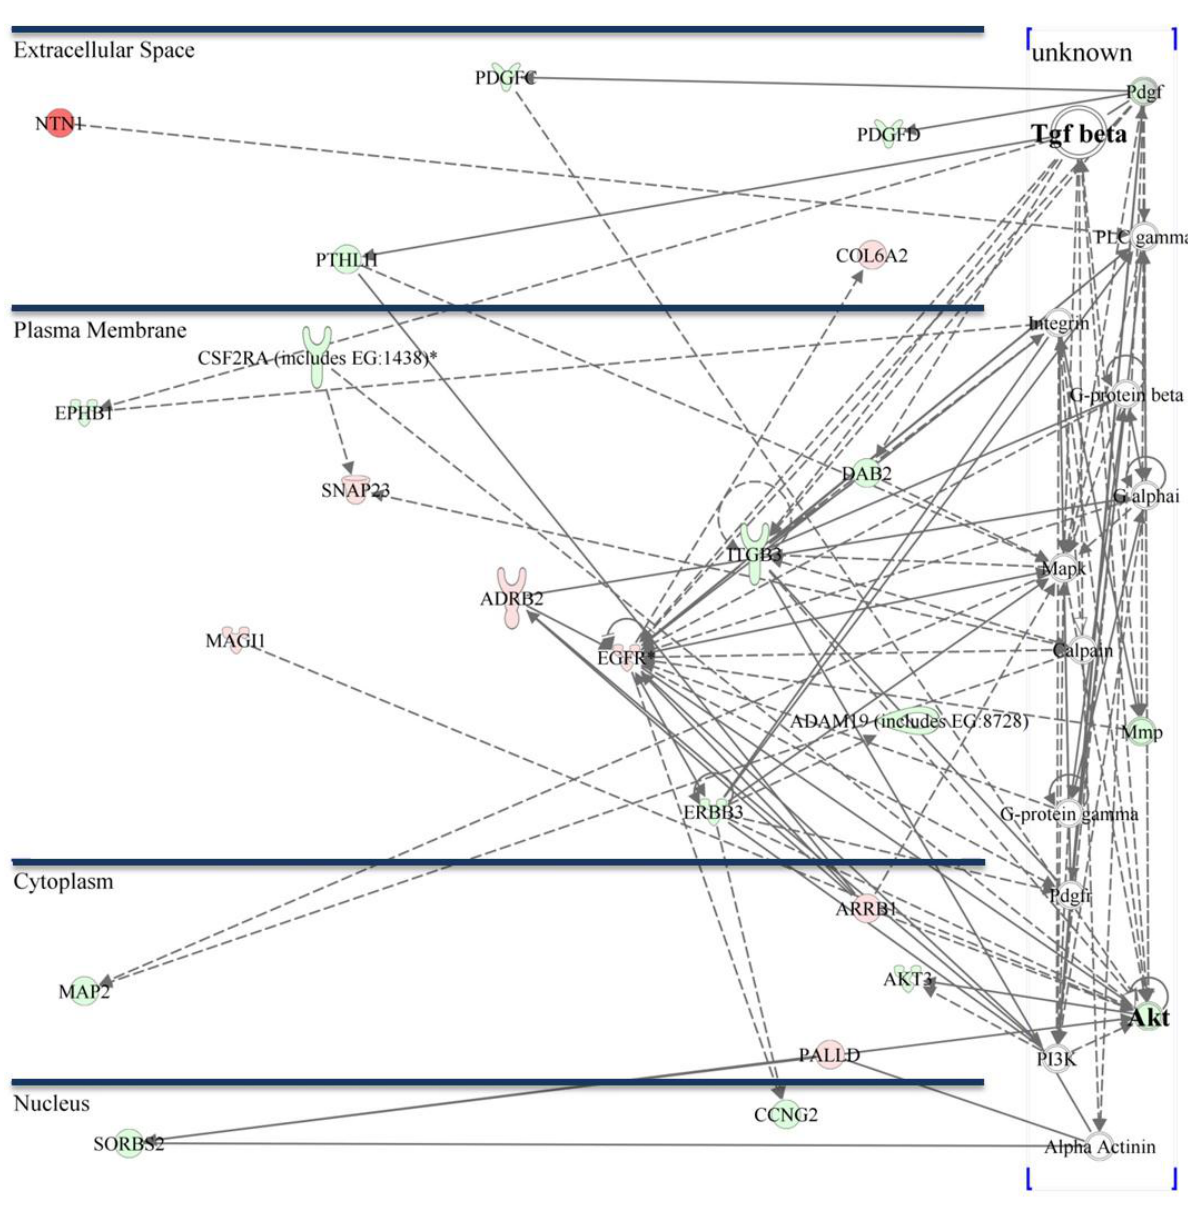
Figure 5. Immunoblot analysis of AKT phosphorylation . The expression of P-AKT (S 473 ), and AKT was assessed in untreated (Mock) and adenovirally infected cells (100 MOI Ad-  E1 control virus or 100 MOI Ad-CTS-1, 30 h, n =